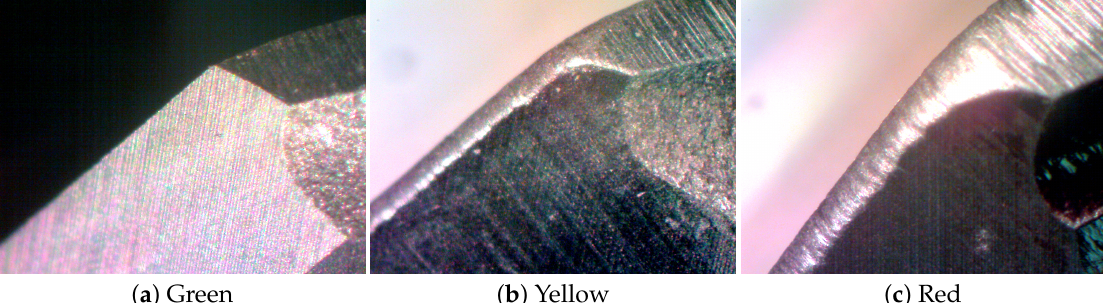
Figure 2. Example images representing holes made by drills with different wear classifications: green ( top ), yellow ( middle ), and red ( bottom ).